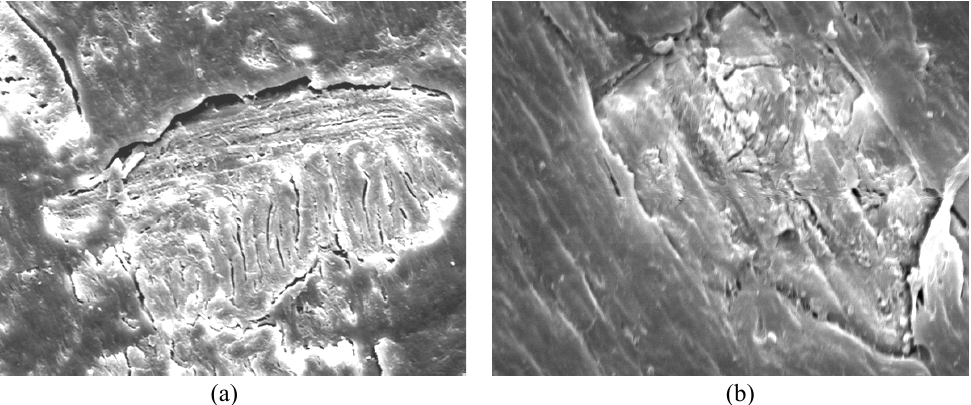
Figure 2. Scanning electron micrographs of PP/OPTP composites from 70% pulp loading with ( a ) 2% Exxelor PO 1020 and ( b ) 4% Exxelor PO 1020 at 2000× magnification.